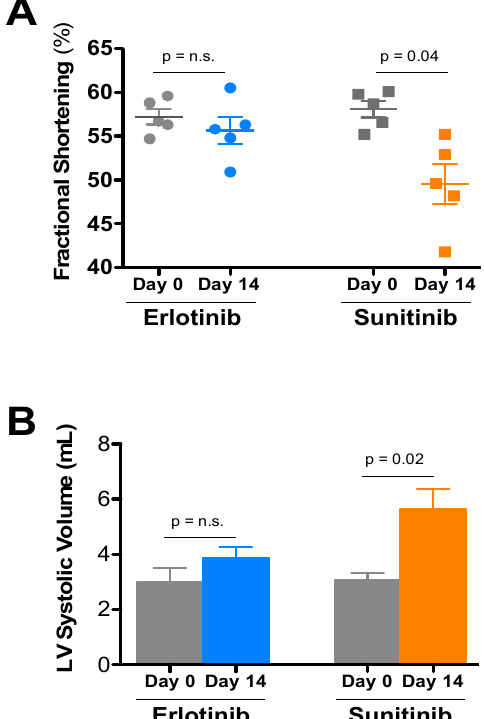
Figure 1. Echocardiographic analysis of the effects of the tyrosine kinase inhibitors erlotinib and sunitinib on cardiac function. FVB/N mice were treated with sunitinib (40 mg/kg), erlotinib (50 mg/kg), or vehicle daily for 2 weeks and serially echoed at baseline and after 2 weeks. ( A ) Fractional shortening % and ( B ) LV Volume (in Systole) at baseline and 14 days of erlotinib (blue), sunitinib (orange), or vehicle control (gray) treatment in vivo. A Student’s t -test was used to determine significance between groups (defined as p < 0.05). Values are expressed as mean values ± SE ( N = 10/group).